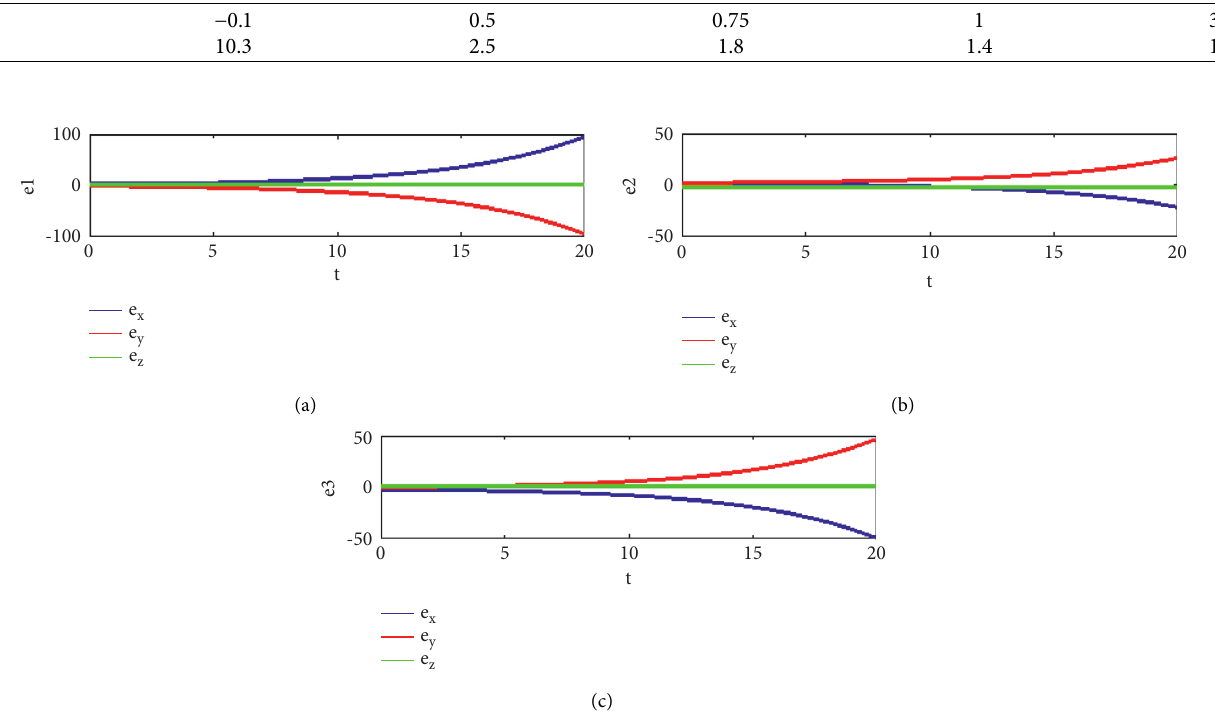
Figure 3: The error trajectories of leader and agents with c � 0 . 75 in Example 1. (a) The error trajectories of v0 and v1. (b) The error trajectories of v0 and v2. (c) The error trajectories of v0 and v3. Table 1: Average time to zero of the variables’ error with increasing c in Example 1.